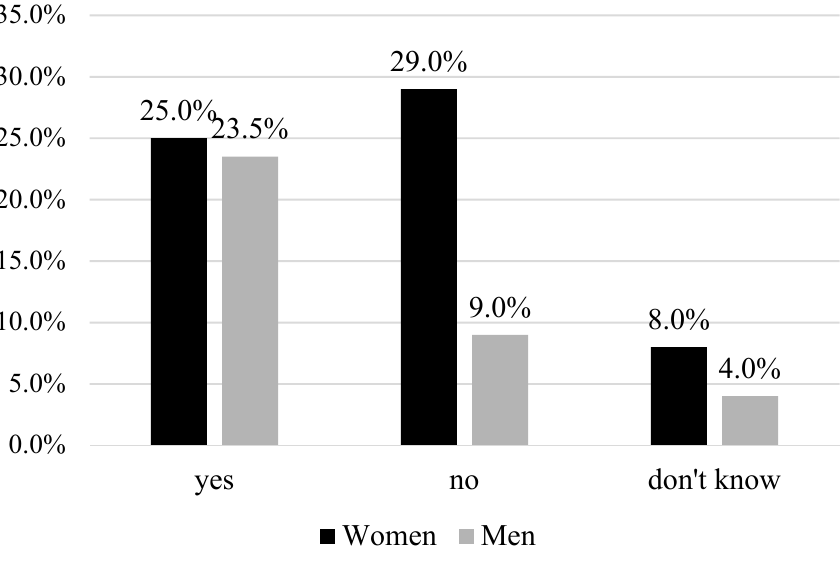
Figure 1. Women’s and men’s readiness to set up a business in the future. Source: Own research.